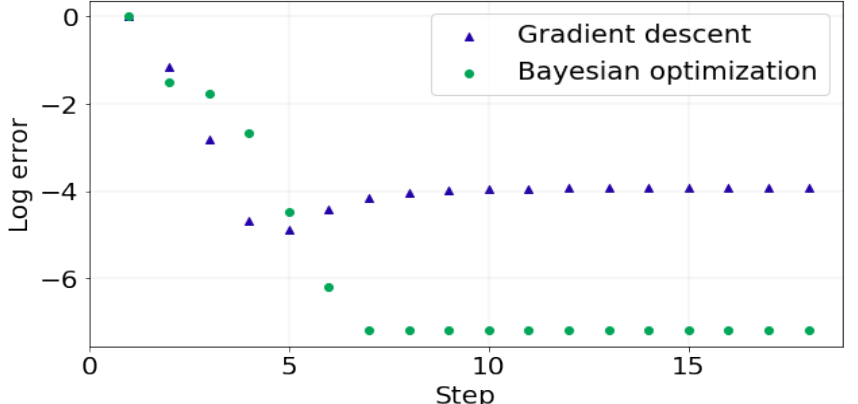
Figure 3. We compare the eBO method with the gradient descent (GD) method on the sphere by calculating the log error, the L2 distance from the true extrinsic mean. Although the eBO method converges slower than the GD method in the first four steps, by adding those stepping points into the eGP, it achieves better numerical precision with more